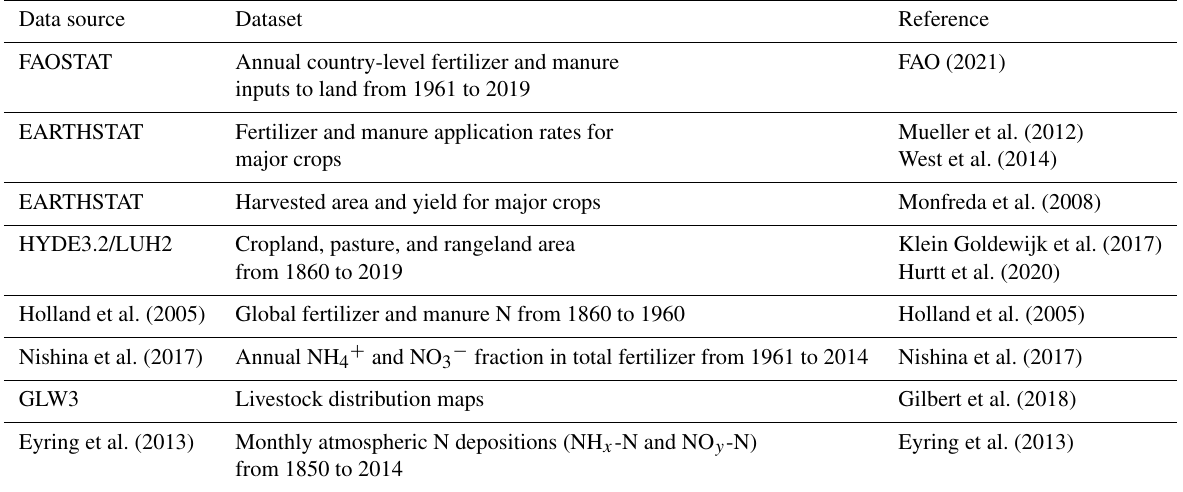
Table 1. Summary of main data